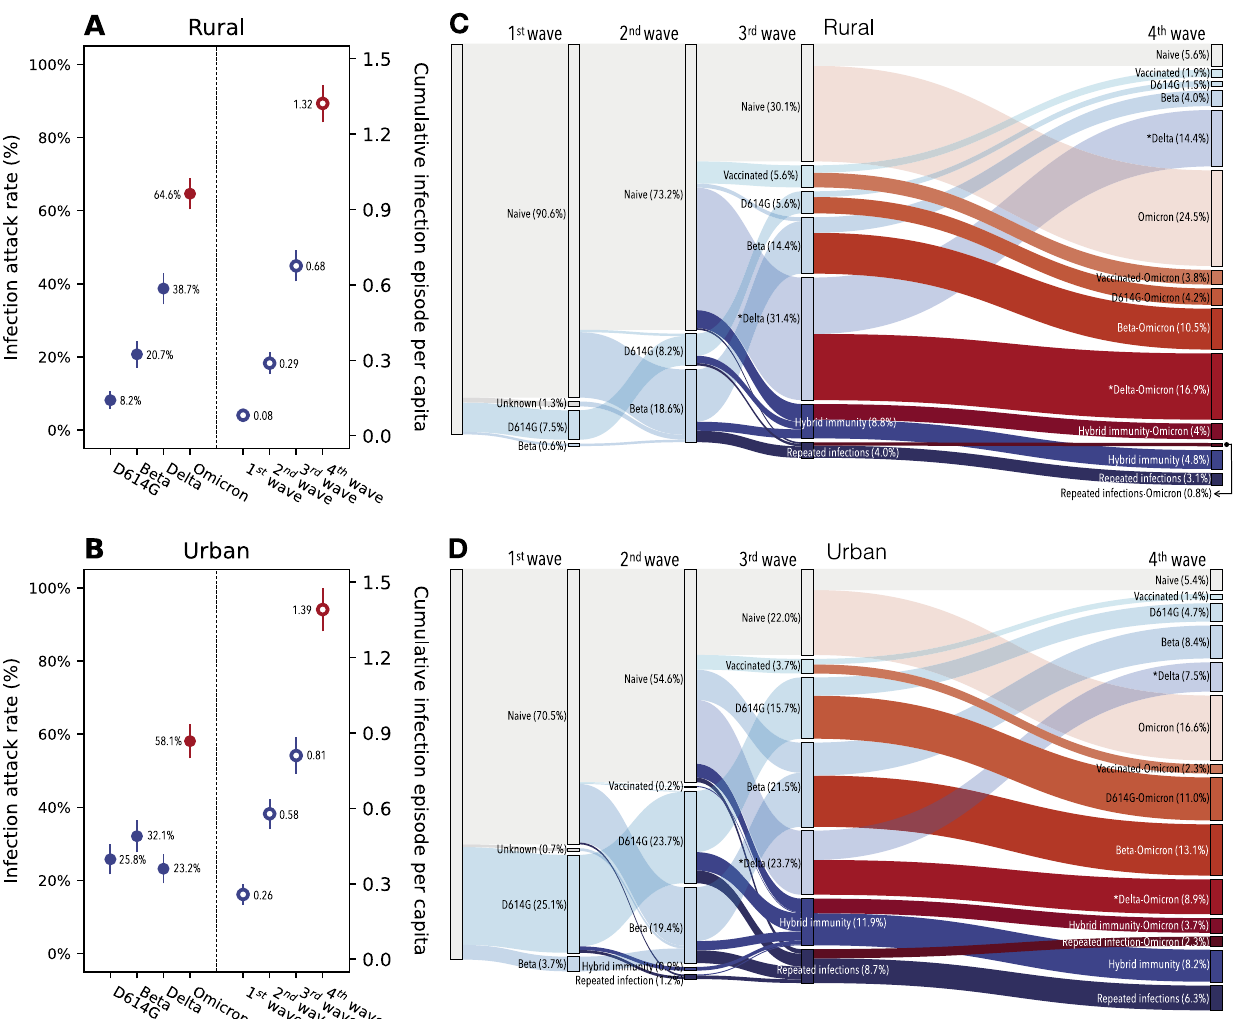
Fig.2|SARS-CoV-2infectionattackratesandshiftsinimmunologiclandscape. A Infection attack rates in the rural site by variant type (left) and the cumulative number of infection episodes per capita after each epidemic wave (right), based on n =905 participants. Dots and lines represent mean and 95% con fi dence intervals. The end of the 1st wave is marked by blood draw 2, 2nd wave is marked by blood draw 5, 3rd wave is marked by blood draw 8, 4th wave is marked by blood draw 10. B Same as ( A ) but for the urban site. C Sankey diagram demonstrating the distribution of different type of immunologic exposures (including vaccination and infection) in the population of the rural site after each epidemic wave and the transition of immunologic exposures in-between waves. In the Sankey diagram, rectan- gular nodes of the same color represent proportion of population of a given immunologic state: gray color represents SARS-CoV-2 immunologic naïve